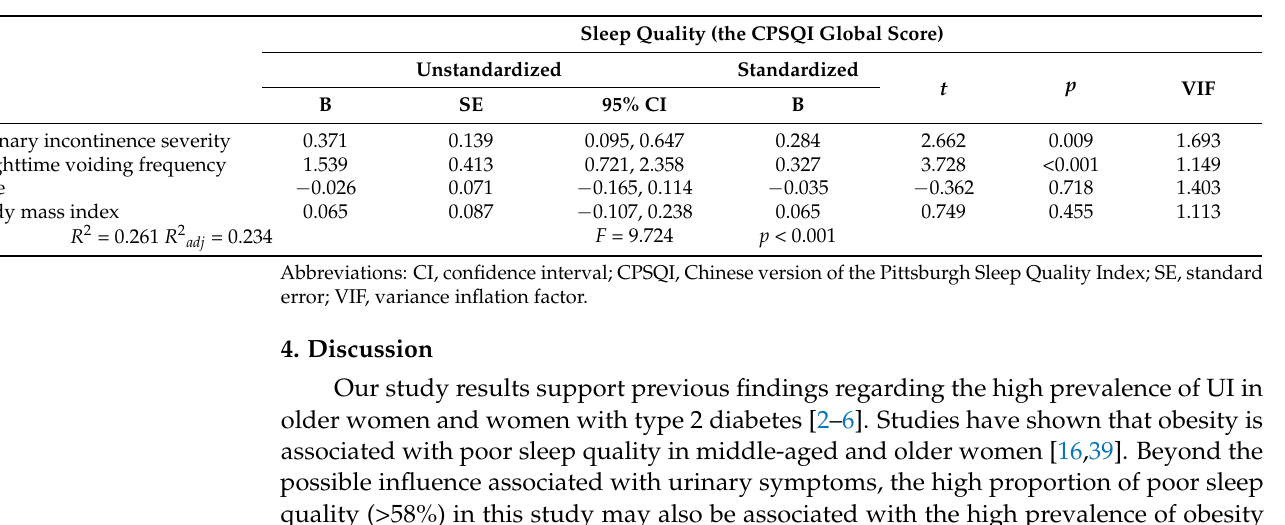
Table 4. Multivariate linear regression of sleep quality in participants with urinary incontinence ( n =